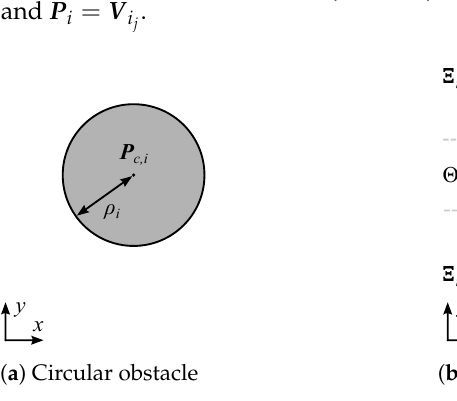
Figure 1. Obstacles model.